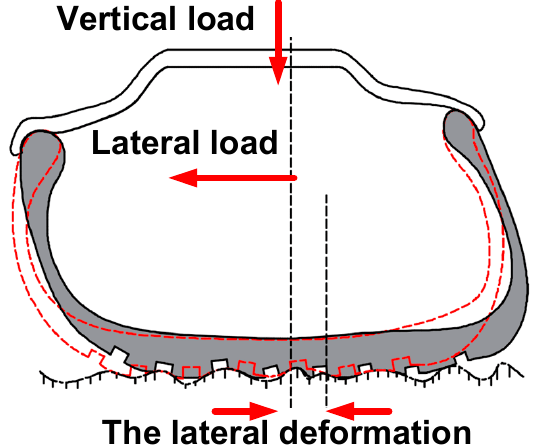
Figure 2. Diagram of tire–pavement contact patch.